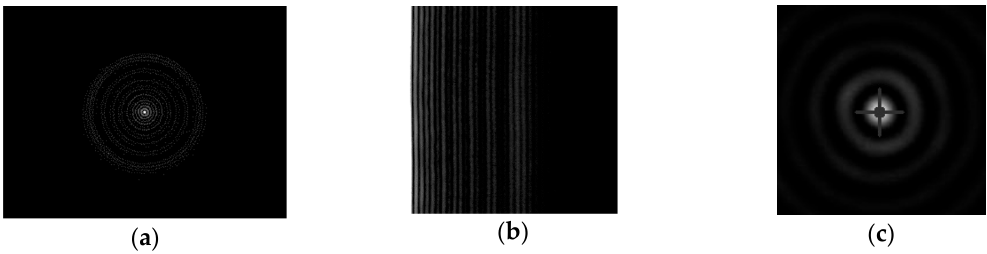
Figure 14. Working sequence of the algorithms: input image ( a ); best polar plot ( b ); center with minimum sum of variances (VAR-basef algorithm) or minimum sum of pixel intensities (FFT-based algorithm) ( c ).